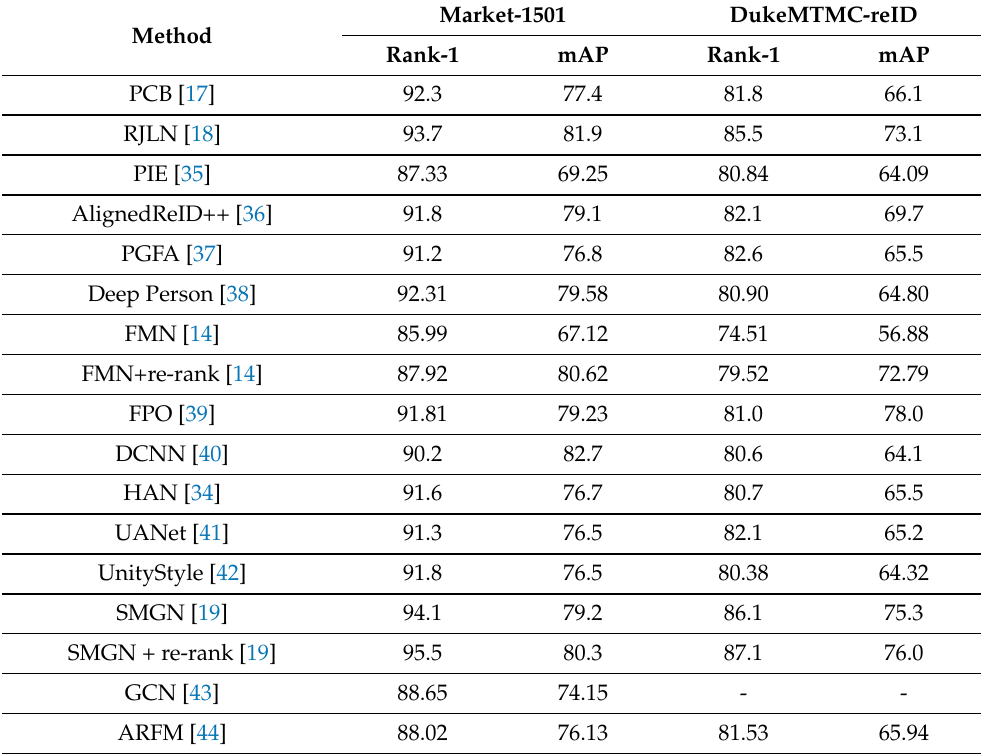
Table 3. Network technical change comparison on the Market-1501